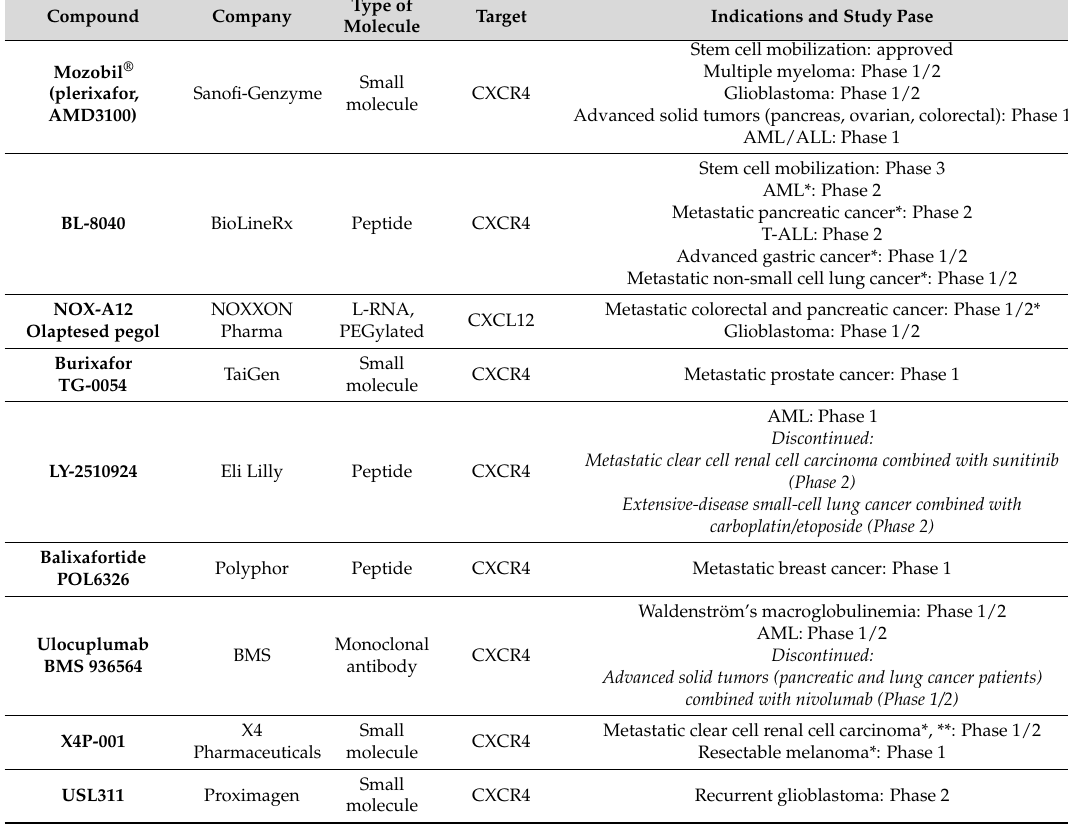
Table 1. Antagonists of the CXCL12/CXCR4/ACKR3 axis currently in clinical development for cancer.